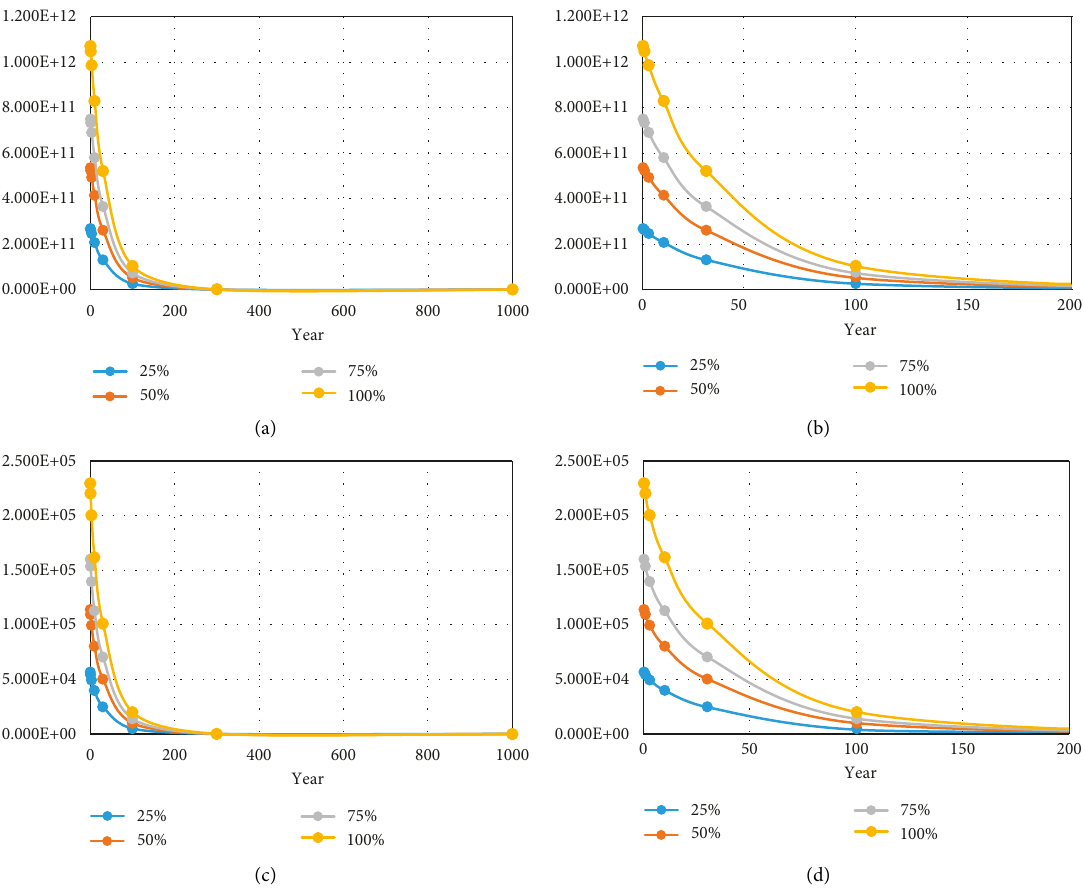
Figure 2: Radiological characteristics of Cs waste/waste form according to capture rate ((b) and (d) correspond to magnified graphs of (a) and (c),